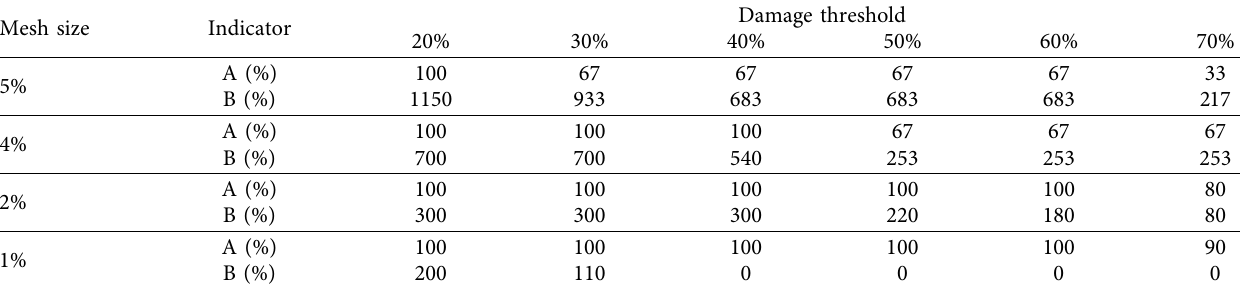
Table 8: Damage capacity indicators for the first preliminary damaged